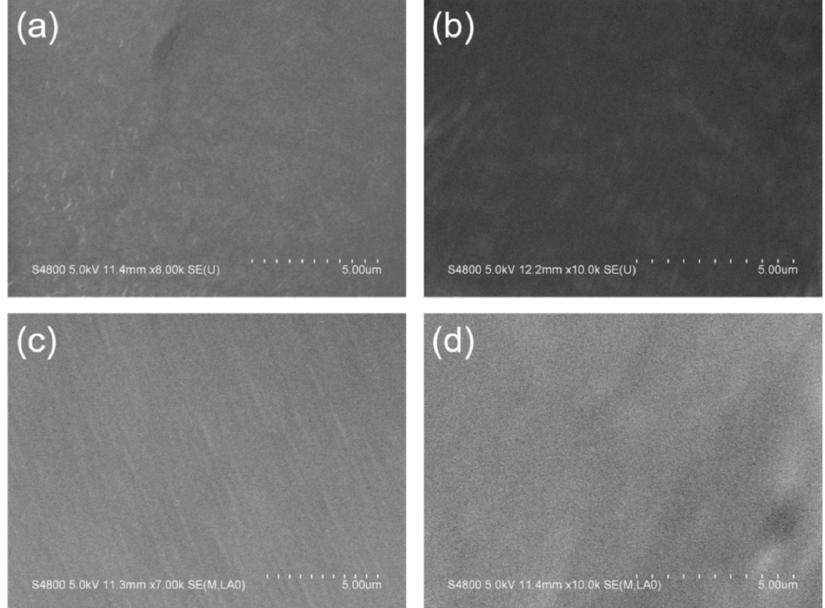
Figure 14. H-PAAS-LHL covered the whole PP-H-PAAS surfaces. Noted that the image ( a – d ) referred to sample 1 to 4 respectively, as compared to the surfaces in Figure 2 ( a – d